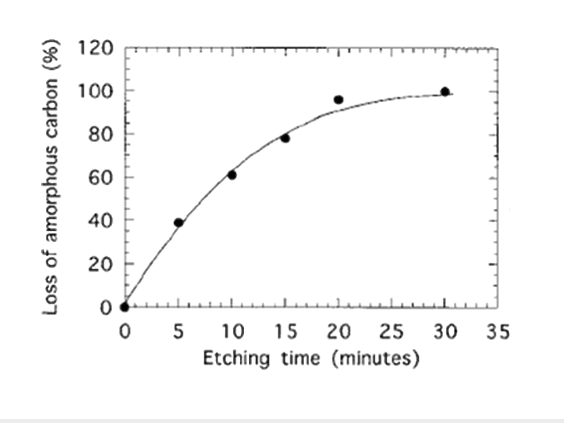
Figure 11: Percentage weight loss of amorphous carbon as a function of the H 2 O-plasma etching time. The H 2 O-plasma etching was performed at 250 kHz, 30 W, and 0.62 Torr. Adapted with permission from [21]. Copyright 2002 American Chemical Society.